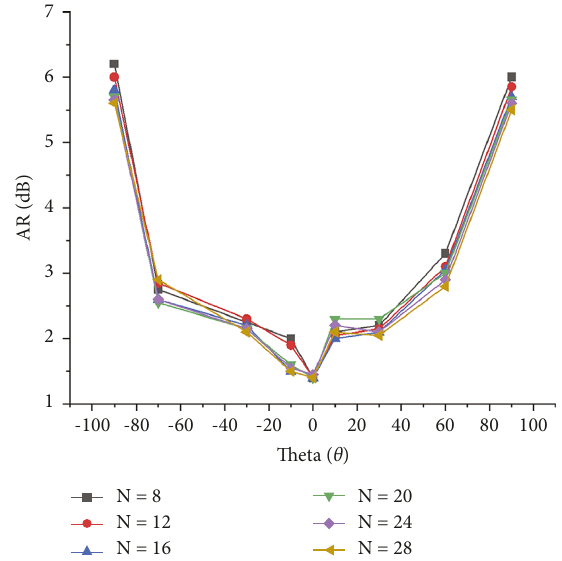
Figure 4: Influence of the trapezoidal number on the antenna axis